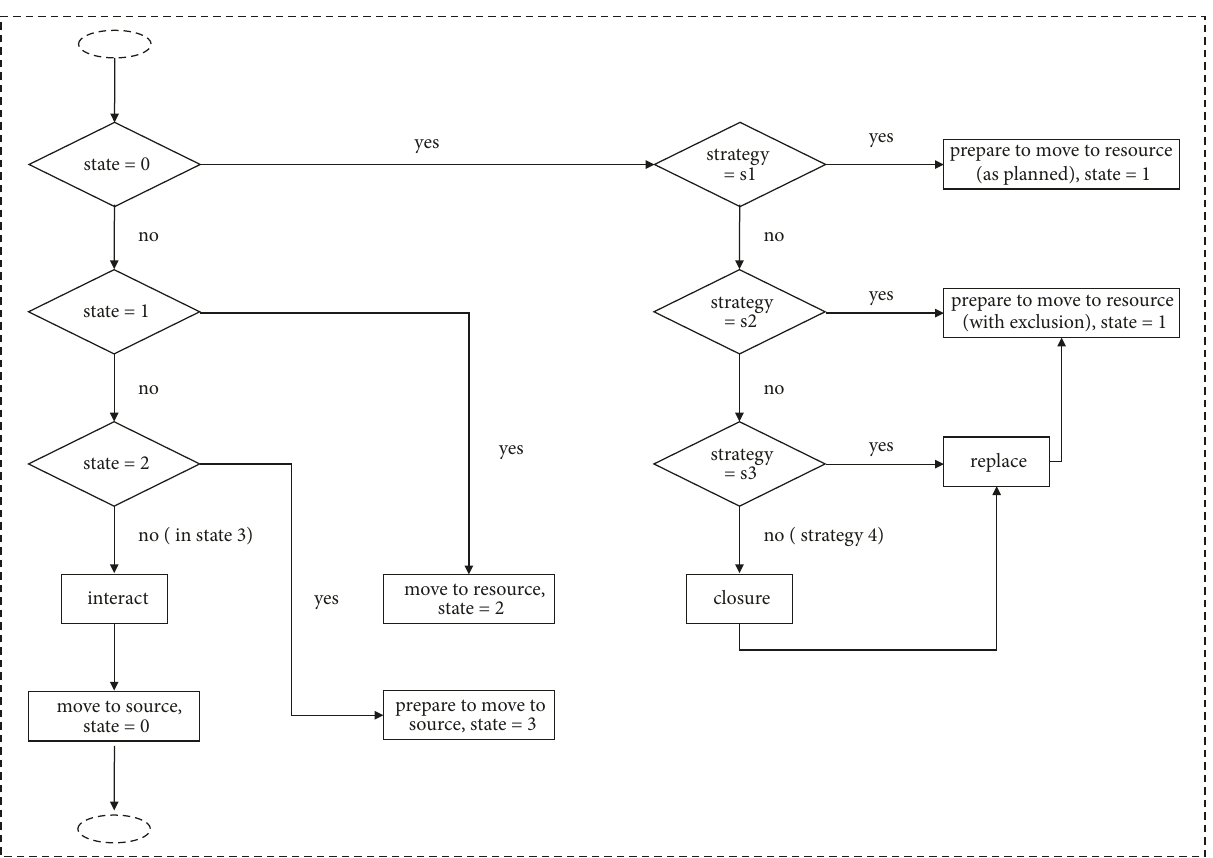
Figure 2: State transition diagram representing the process to be performed at each iteration (= one hour) of the simulation by all the agents. State transition also includes strategy positioning in the system flow.